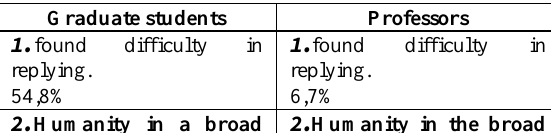
Table 1. Monitoring of respondents' perceptions about the humanization of higher